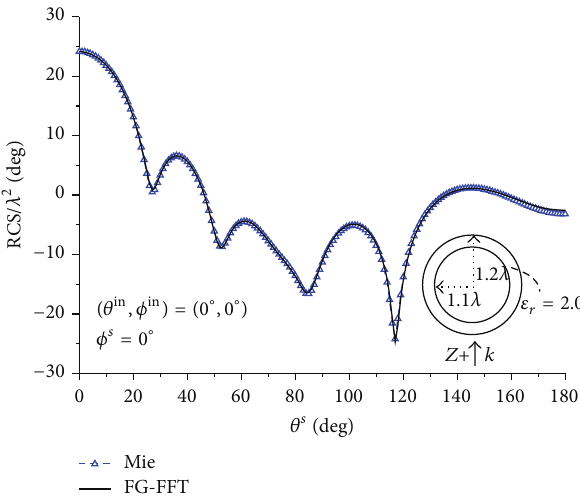
Figure 4: Bistatic RCS curves of the dielectric spherical shell in Example